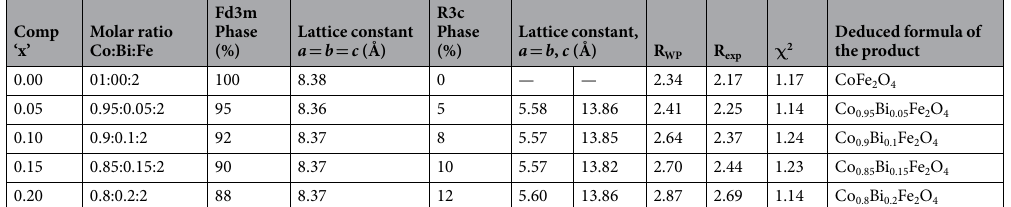
Table 1. Molar ratio, phase analysis, lattice constant and Rietveld refinement parameter i.e. R wp , R exp , and χ 2 of CBF samples.